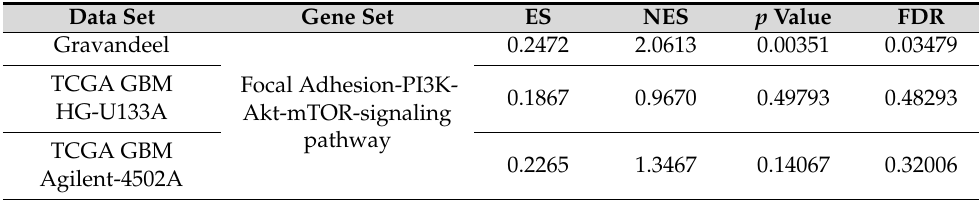
Table 1. The Focal Adhesion-PI3K-AKT-mTOR pathway appeared in all three ASAH1 correlation analyses. Data represent enrichment scores (ES), normalized enrichment scores (NES), p values, and false discovery rate (FDR) for the Focal Adhesion-PI3K-AKT-mTOR pathway in each dataset. Data Set Gene Set ES NES p Value FDR Gravandeel 0.2472 2.0613 0.00351 0.03479 TCGA GBM Focal Adhesion-PI3K- 0.1867 0.9670 0.49793 0.48293 HG-U133A Akt-mTOR-signaling pathway TCGA GBM 0.2265 1.3467 0.14067 Agilent-4502A